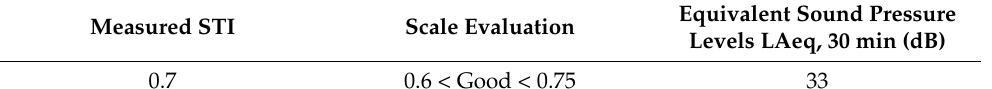
Table 2. Speech Transmission Index of the Ponchielli theater of Cremona.